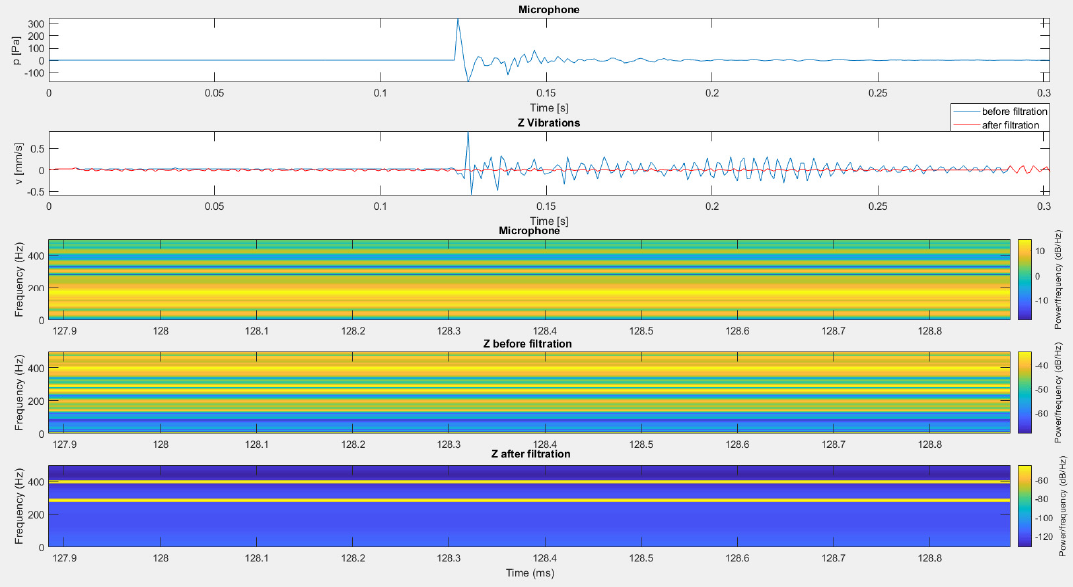
Figure 15. The result of using filtration for the data from the recording shown in Figure 7 (test No. I) for the vertical component from a sensor located directly on the floor.